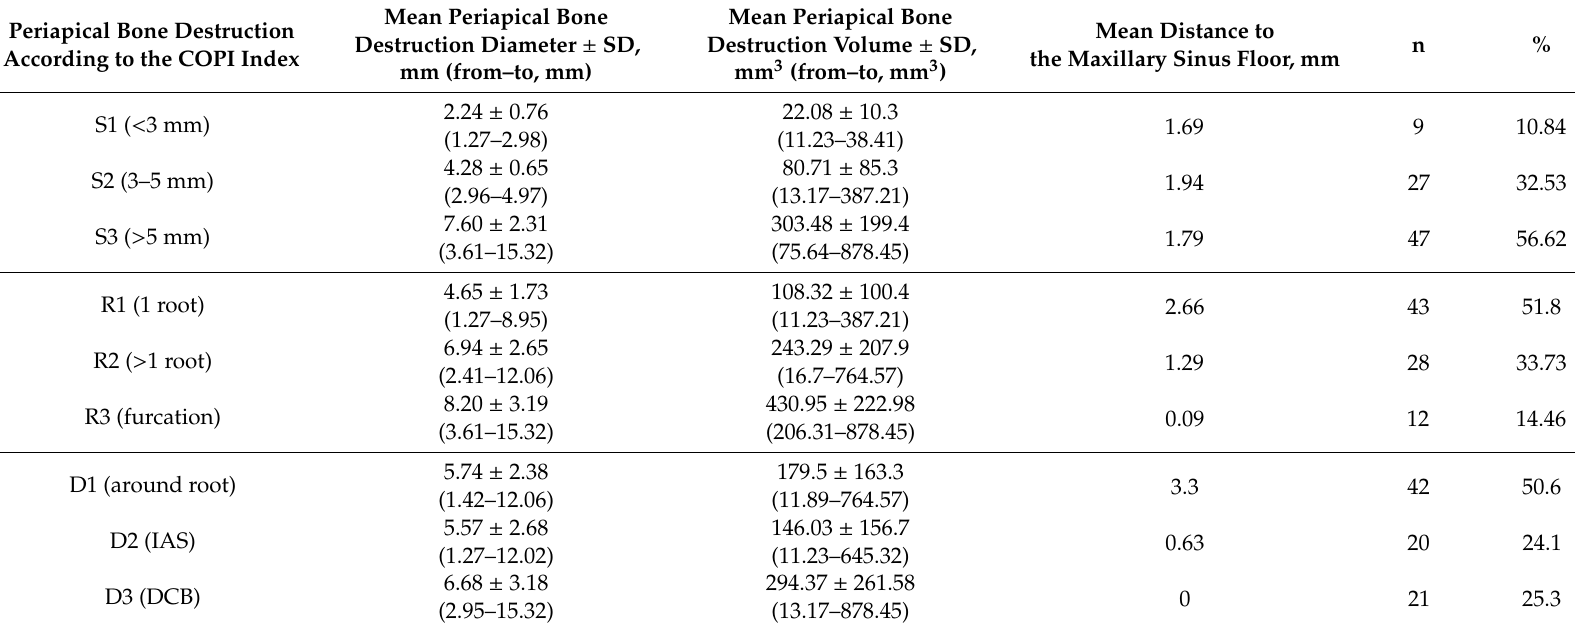
Table 2. The detailed analysis of periapical bone lesions according to the COPI index. IAS—Radiolucency is in contact with important anatomical structures; DCB—destruction of cortical